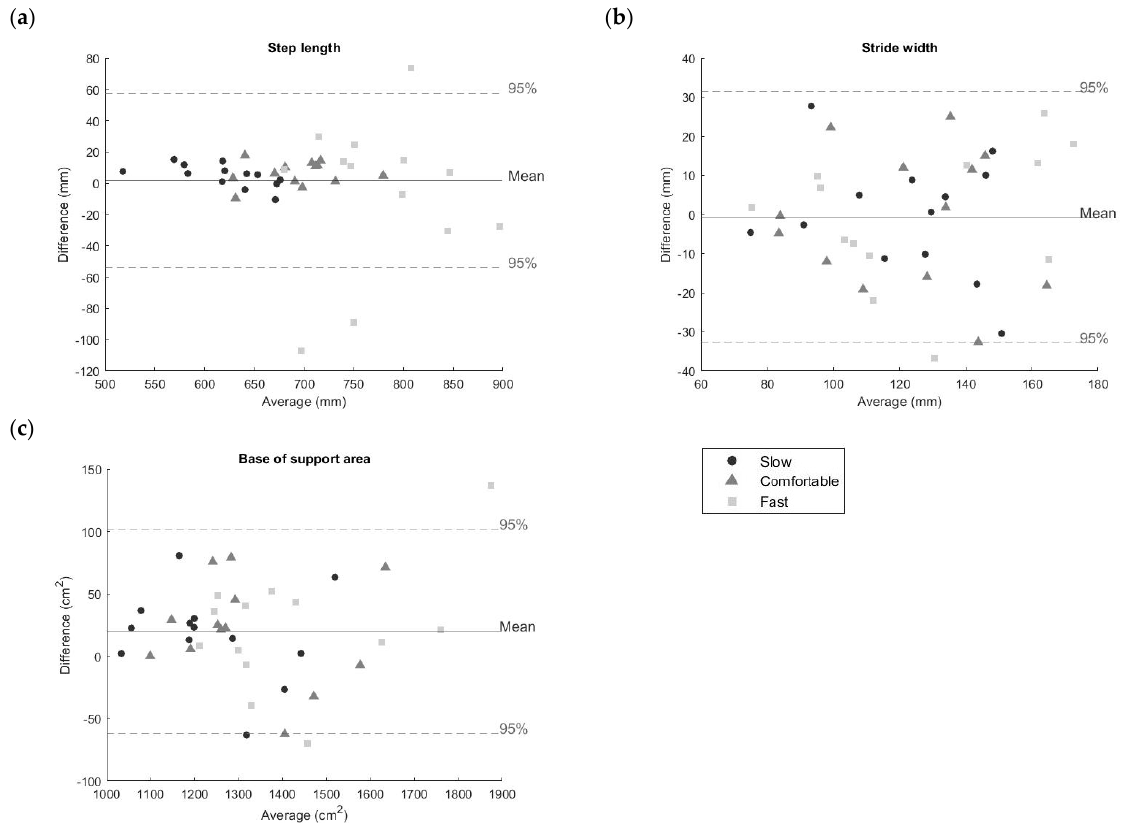
For each parameter, Bland–Altman plots are reported in Figure 13.